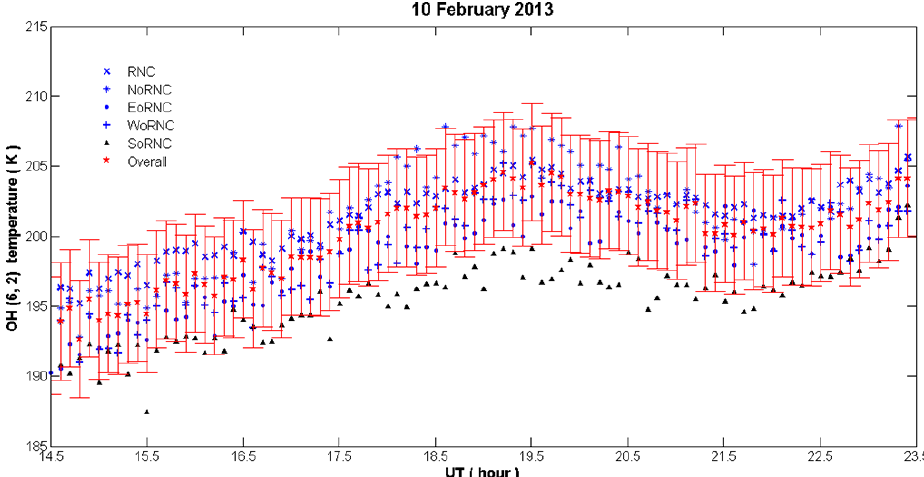
Figure 2. Nocturnal variation of T OH at different sampling locations on 10 February